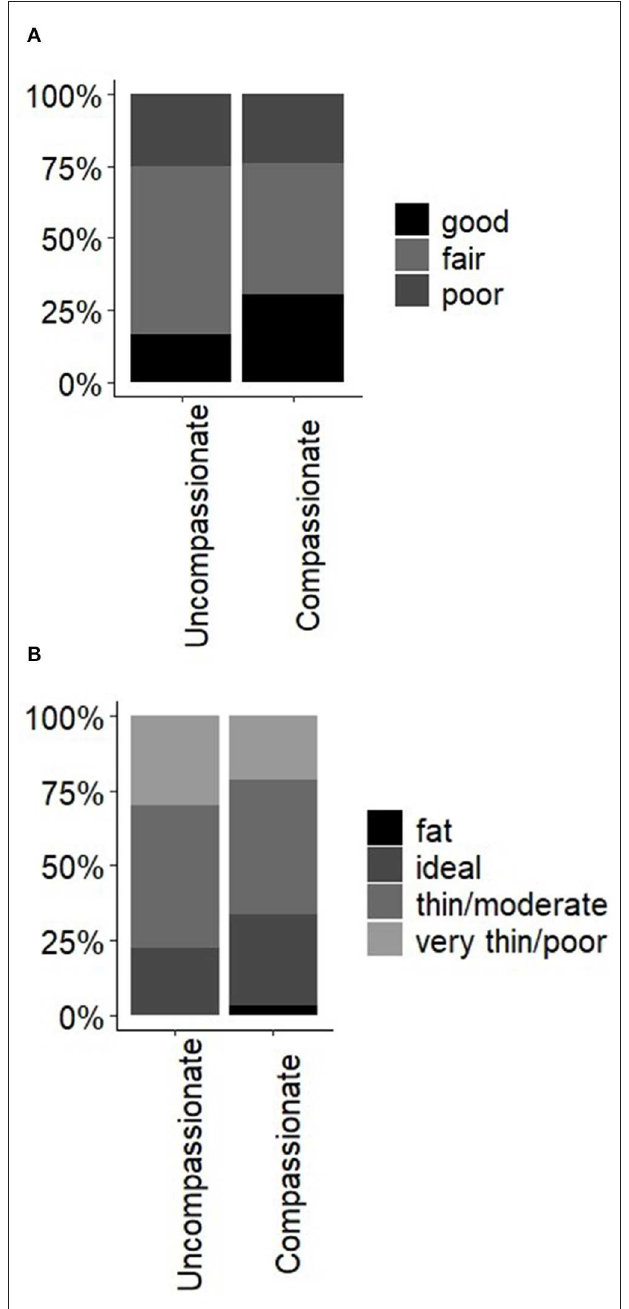
FIGURE 2 | Percentage of donkeys that obtained (A) “good,” “fair,” and “poor” general health scores and (B) each body condition score, grouped by whether owner used or lacked compassionate language when relating to their